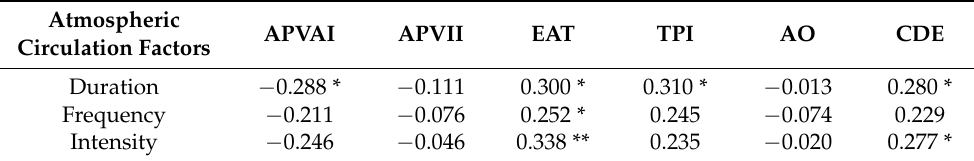
Table 2. Correlation between the influencing factors and the characterizations of heatwaves in Hexi